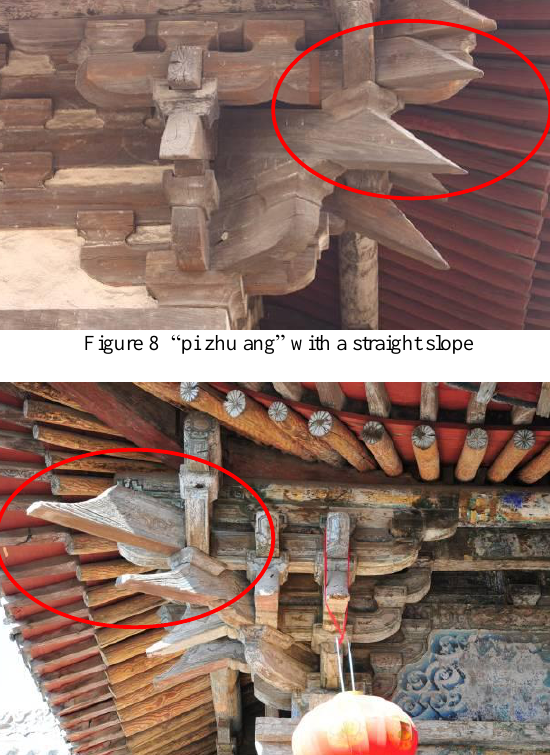
Figure 11 beam head comes out at the corner